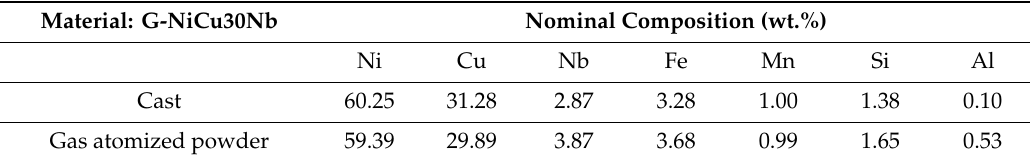
Table 1. Nominal composition (wt.%) of the cast and gas atomized powder. Material: